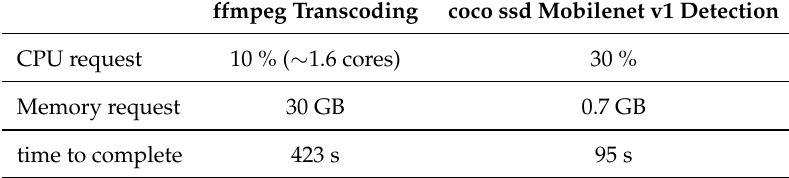
Table 1. Metrics for running the two individual annotation steps tested (transcoding and Convolution Neural Network (CNN) object detection) in a single node cluster. From these values, an estimate of the resources required for each of the jobs is obtained.